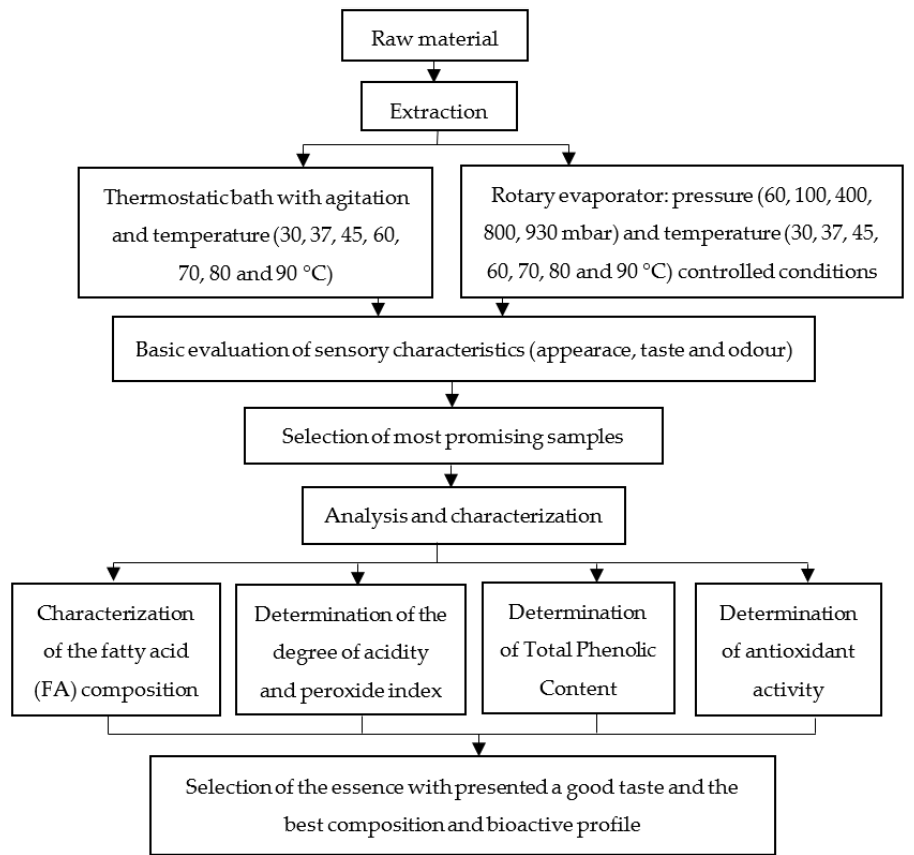
Figure 1. Protocol followed to perform this study .